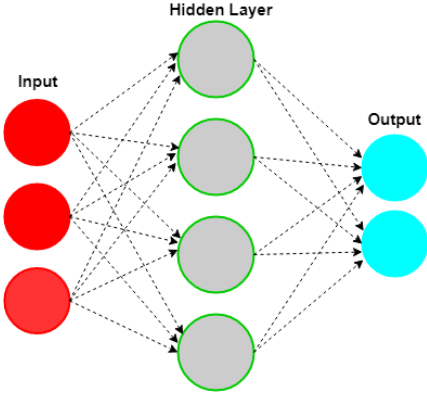
Figure 2. Structure of